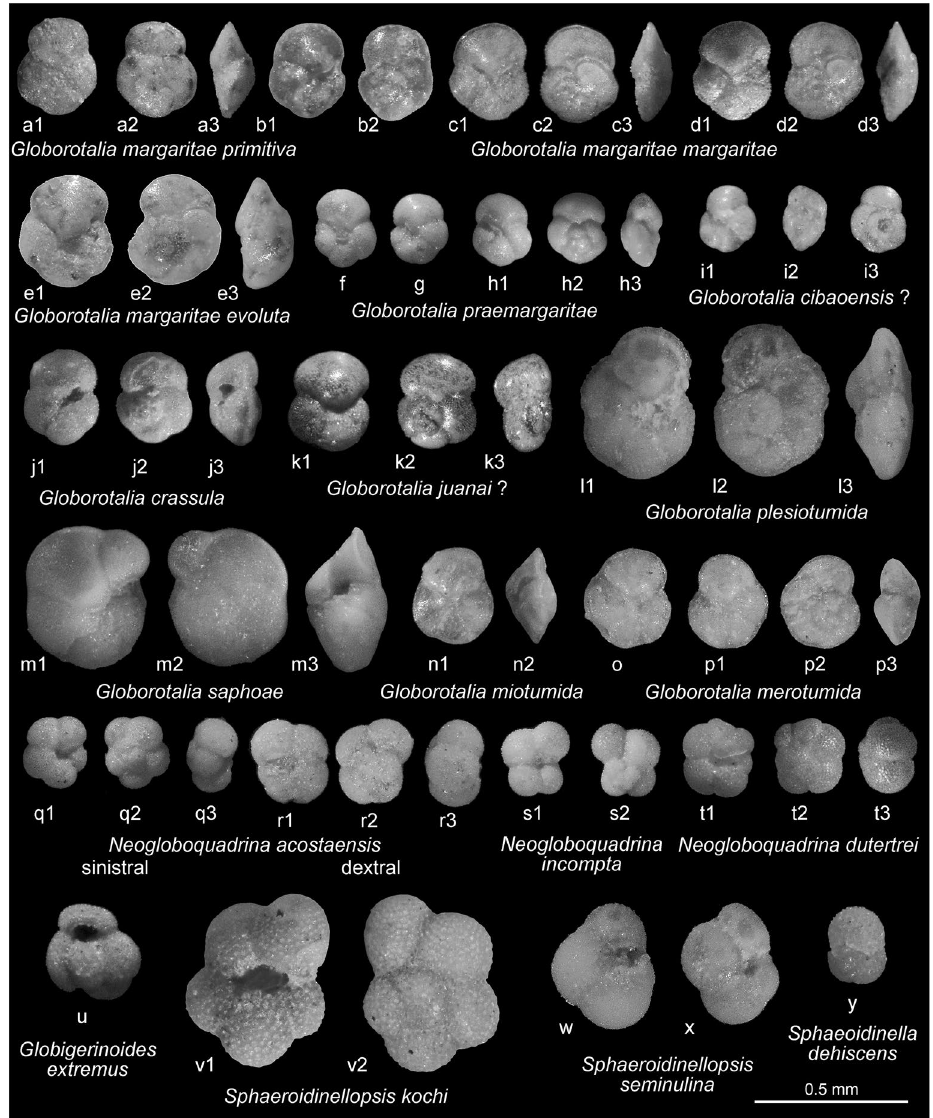
Fig. 6 Photoplate of selected planktonic foraminifera deemed of stratigraphic significance. Globorotalia margaritae primitiva : a Sidi Mohamed ech Chleuh (section 2), Zanclean level 2. Globorotalia margaritae margaritae : b , Kef Nsour (section 4), higher Zanclean; c , d , Sidi Mohamed ech Chleuh (section 2), Zanclean level 2;. Globorotalia margaritae evoluta : e , Kef Nsour (section 4), higher Zanclean. Globorotalia praemargaritae : f – h , Sidi bou Sensal (sections 6 and 7), Tortonian clay. Globorotalia cibaoensis ?: i Sidi Mohamed ech Chleuh (section 2), Zanclean level 1. Globorotalia crassula : j Kef Nsour (section 4), basal Zanclean. Globorotalia juanai ?: k Jebel Zebbouj (section 3), higher Zanclean. Globorotalia plesiotumida : l Sidi bou Sensal (section 7), basal Tortonian mudstone. Globorotalia saphoae : m Sidi bou Sensal (section 7), Tortonian clay. Globorotalia miotumida : n Sidi Mohamed ech Chleuh (section 2), Zanclean level 2 (presumed reworked). Globorotalia merotumida : o , p Dar bel Hamri (section 1), Zanclean, yellow sands of Dar bel Hamri (presumed reworked). Neogloboquadrina acostaensis : q Sidi bou Sensal (section 7), Tortonian clay; r Kef Nsour (section 4), basal Zanclean. Neogloboquadrina incompta : s Sidi bou Sensal (section 6), Tortonian clay. Neogloboquadrina dutertrei : t Jebel Zebbouj (section 3), higher Zanclean. Globigerinoides extremus : u Jebel Zebbouj (section 3), higher Zanclean. Sphaeroidinellopsis kochi : v Dar bel Hamri (section 1), coquina. Sphaeroidinellopsis seminulina : w , x Sidi bou Sensal (section 7), Tortonian clay. Sphaeroidinella dehiscens : y Jebel Zebbouj (section 3), higher